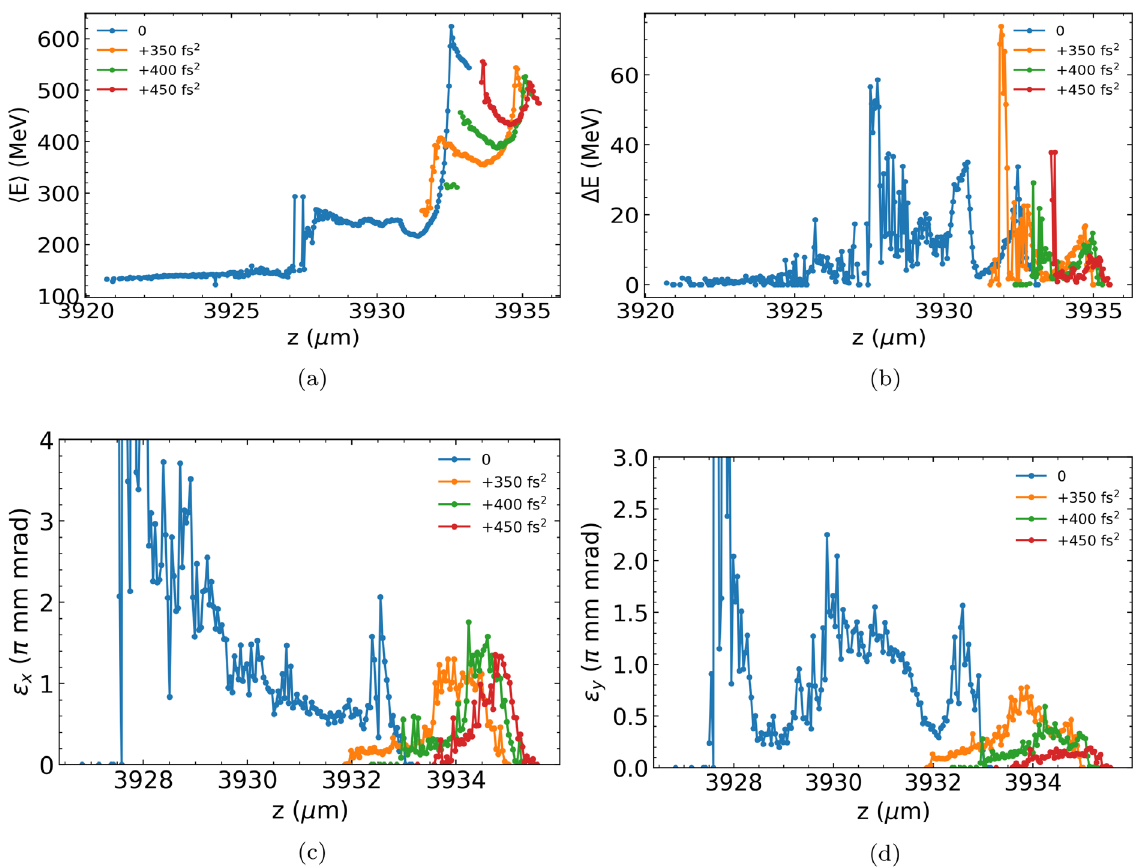
FIG. 3. The improved bunch quality of accelerated electrons is obtained for a linearly chirped laser pulse. Slice distribution of (a) average electron energy h E i , (b) energy spread of electrons Δ E , and (c) and (d) normalized rms emittance ϵ x (in the x direction) and ϵ y direction) of the injected electron bunch for different values of group delay dispersion ( ϕ ð 2 Þ ) with slice length of 40 nm y (in the around z ¼ 3 . 9